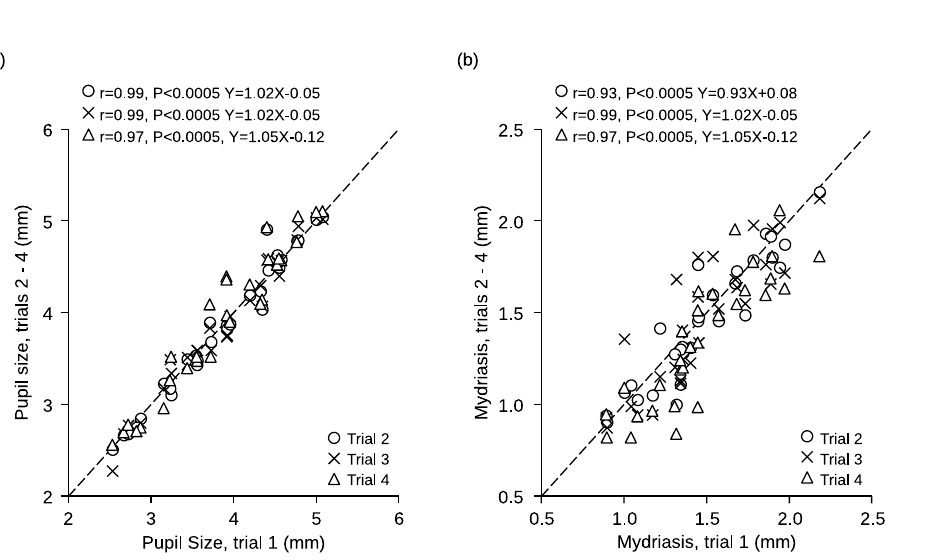
Figure 1. Stability of pupil size measurements in different experimental sessions. The average pupil size at rest (a) and the mydriasis elicited by a haptic task (b) have been recorded in four different experimental sessions (trials). Values relative to the second, third and fourth trial have been plotted as a function of the initial value. The corresponding coefficients of correlation and regression lines equations have been reported in both ( a ) and ( b ). Dotted lines represent equal values on X and Y